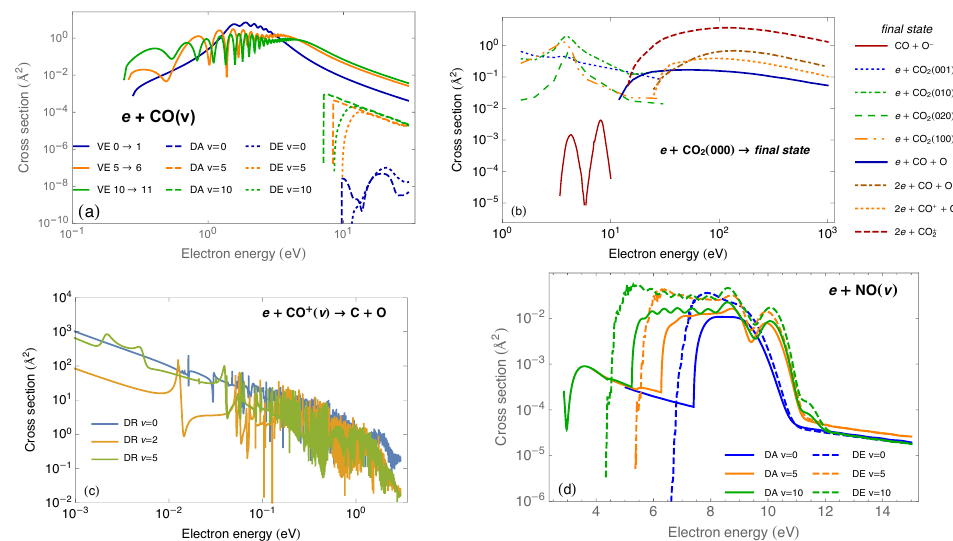
Figure 8. Compilation of state-resolved cross sections by electron-impact: ( a ) electron-CO [100,101]; ( b ) electron-CO 2 [105]; ( c ) electron-CO + [104]; ( d ) electron-NO [102,103]. Processes of: Vibrational Excitation (VE); Dissociative Attachment (DA); Dissociative Recombination (DR); Dissociative Excita- tion